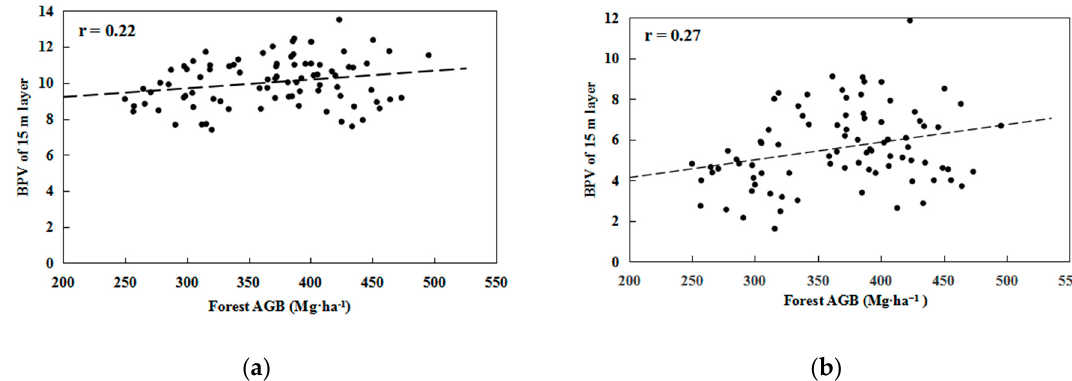
Figure 11. Correlation of backscattered power and forest AGB before ( a ) and after ( b ) terrain compensation in 15 m height layer.